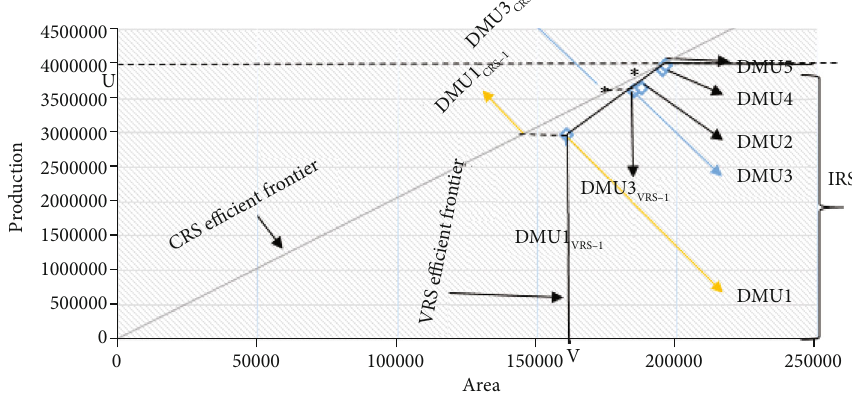
Figure 5: DMU1 to DMU4 face (increase return scale).